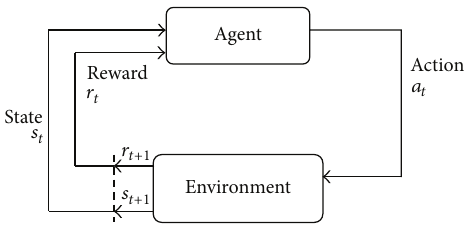
Figure 1: The framework of reinforcement